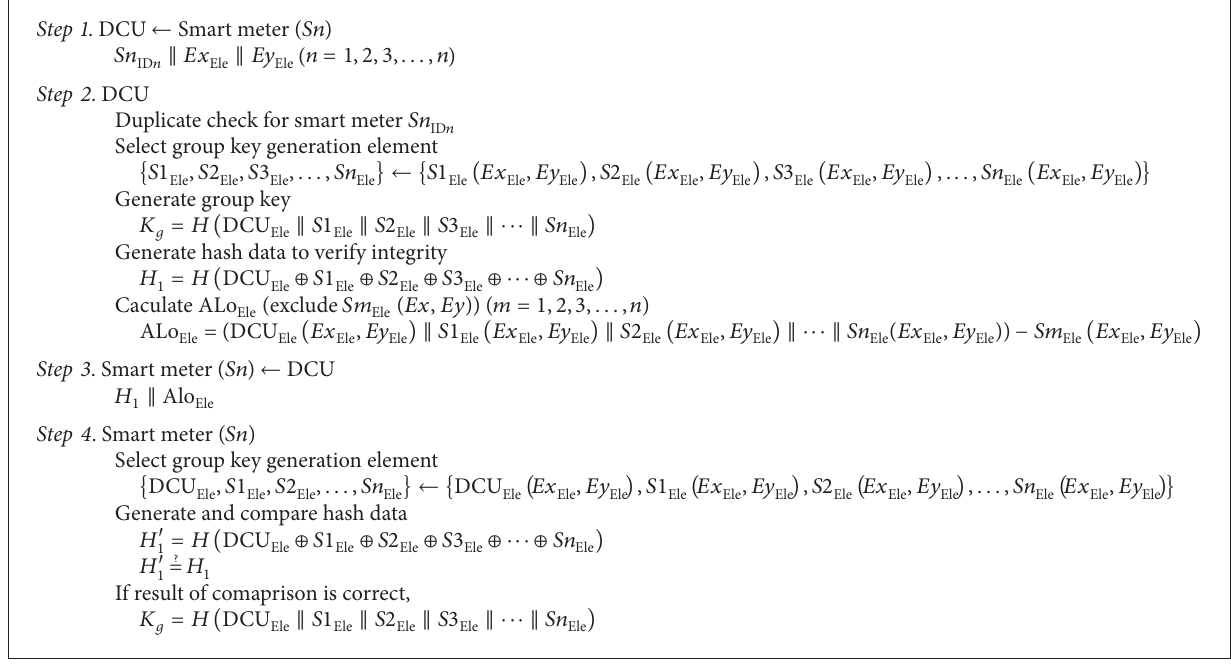
Algorithm 2: Generation of group key. Table 4: Comparison with existing scheme and proposed